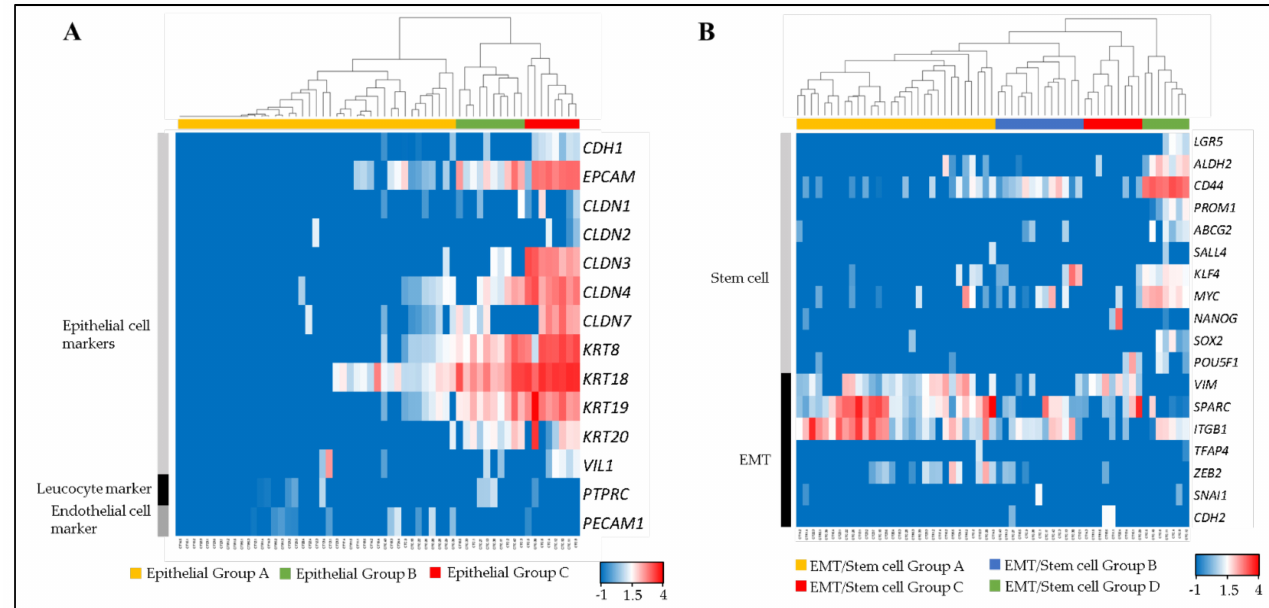
Figure 3. Molecular phenotyping of single CTCs and CTC-clusters. The dendrogram shows cell type clusters and the heatmap shows the log10 (FPM) values of cell-type markers. ( A ) Heatmap showing the raw log10 (FPM) values for known markers of epithelial cells ( CDH1 , EPCAM , CLDN1 , CLDN2 , CLDN3 , CLDN4 , CLDN7 , KRT8 , KRT18 , KRT19 , KRT20 and VIL1 ), leukocytes ( PTPRC ), and endothelial cells ( PECAM1 ). ( B ) Heatmap showing the raw log10 (FPM) values for known markers of stem cells ( LGR5 , ALDH2 , CD44 , PROM1 , ABCB2 , SALL4 , KLF4 , MYC , NANOG , SOX2 and POU5F1 ) and EMT ( VIM , SPARC , ITGB1 , TFAP4 , ZEB2 , SNAI1 and CDH2